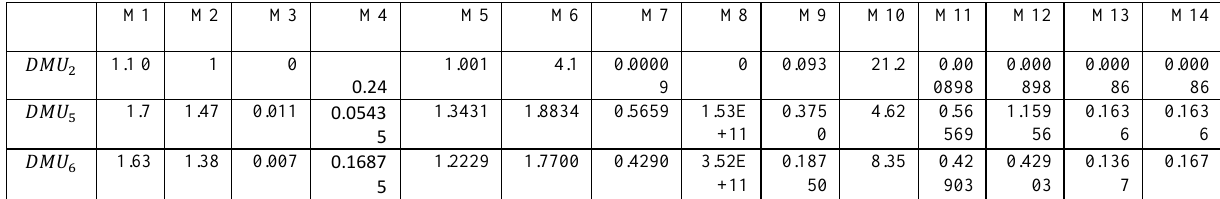
Table3 : Ranking model’s objective function values for efficient units